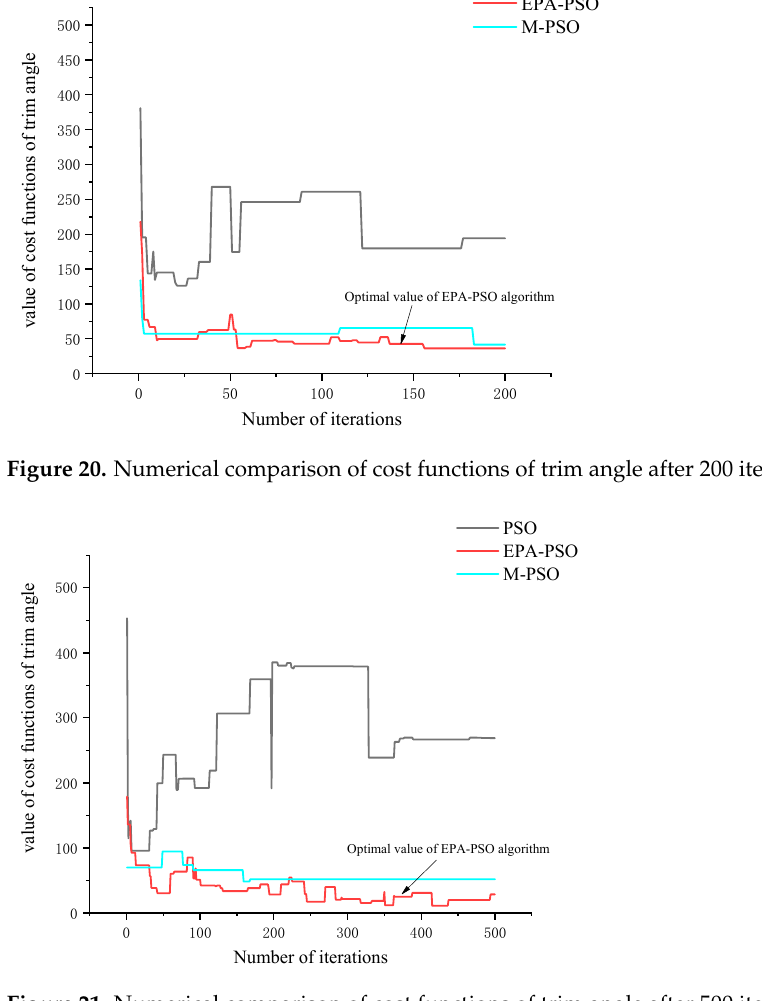
Figure 21. Numerical comparison of cost functions of trim angle after 500 iterations.